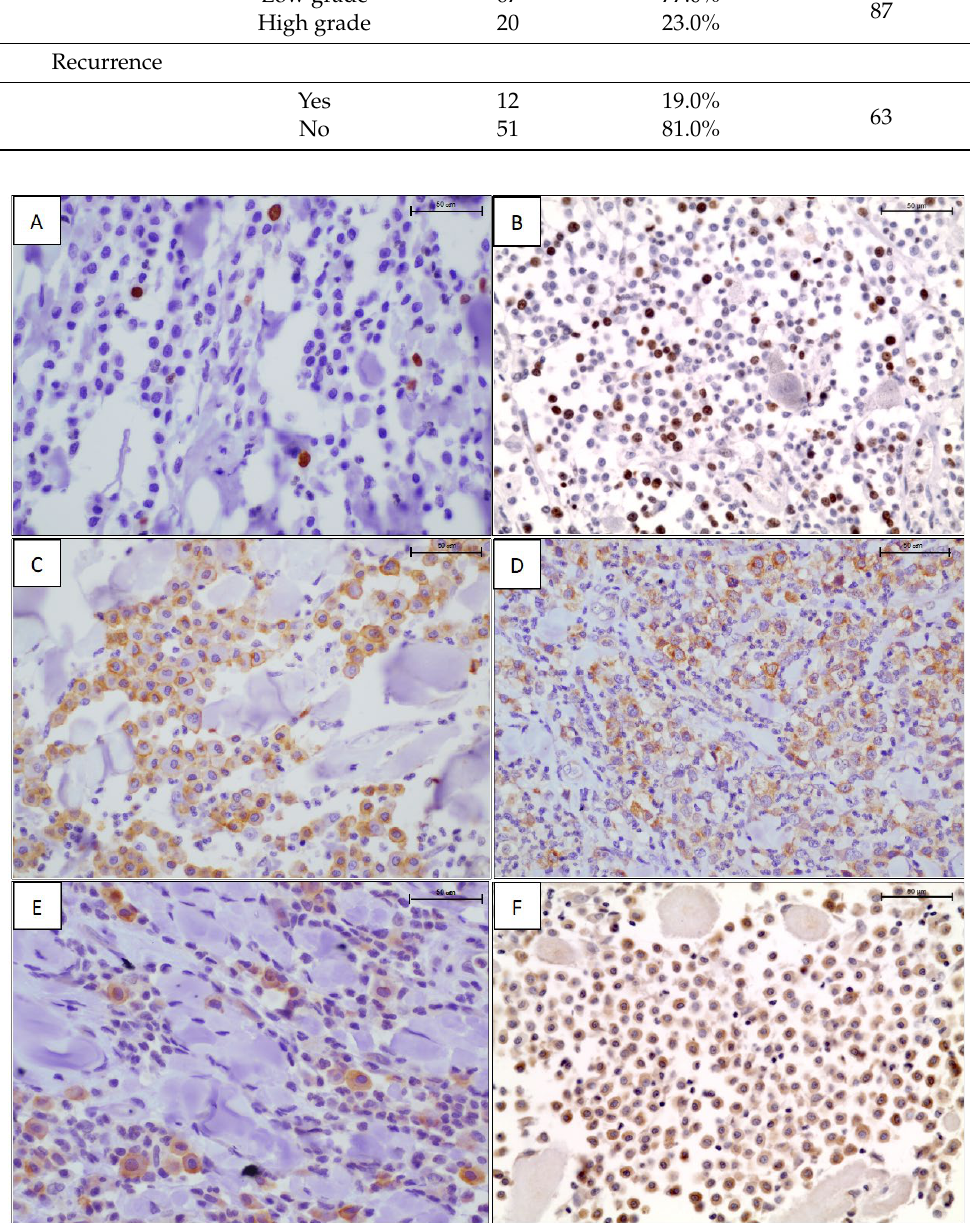
Figure 1. Ki-67 immunostaining: scattered ( A ) and several ( B ), intensely positive nuclei in neoplastic mast cells. Labelled streptavidin biotin (LSAB) method IHC, hematoxylin counterstain, scale bar 50 μm. KIT immunostaining using an anti-CD117 antibody: membranous ( C ), perinuclear ( D ), and cytoplasmic ( E ) staining pattern. LSAB method IHC, hematoxylin counterstain, scale bar 50 μm. ( F ) Diffuse cytoplasmic immunoreactivity to the anti-VEGF antibody. LSAB method IHC, hematoxylin counterstain, scale bar 50 μm. According to the modified-TATE classification score, 22/87 (25.3%) MCTs were clas- sified as score 1+ (Figure 2A), 42/87 (48.3%) as score 2+, 23/87 (26.4%) as score 3+ (Figure 2B) (Table 2).